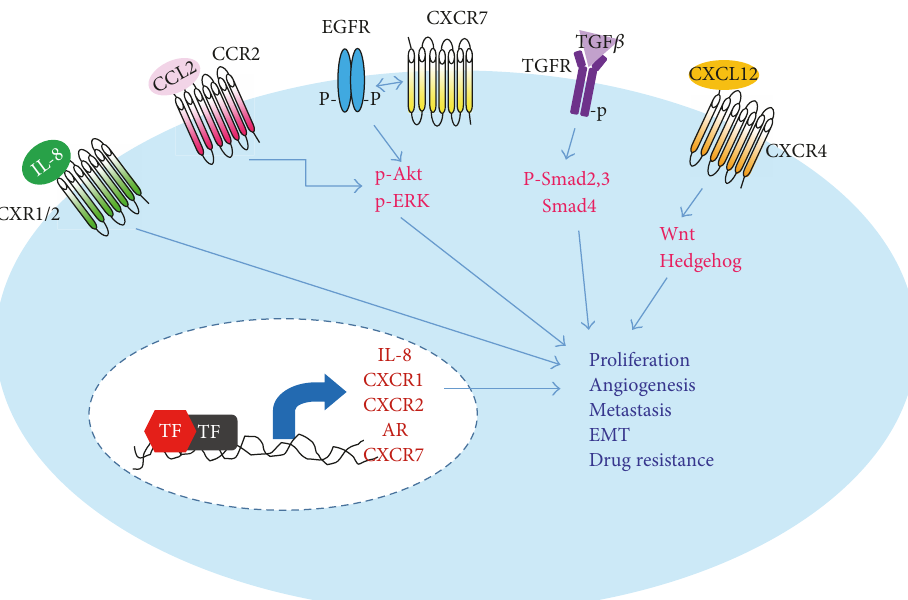
Figure 2: Cytokine signaling of cancer cells on modulation of cell proliferation, angiogenesis, metastasis, and drug resistance. Cytokine signaling pathways utilized by pancreatic and prostatic tumor cells through an autocrine-signaling mechanism to elevate their own growth, angiogenesis, and drug resistance. In addition, upregulation of these signaling molecules also renders tumor cells a more mesenchymal-like phenotype, which in turn, promotes metastasis. TF: transcription factor; IL-8: interleukin-8; AR: androgen receptor; EMT: epithelial mesenchymal transition; p: